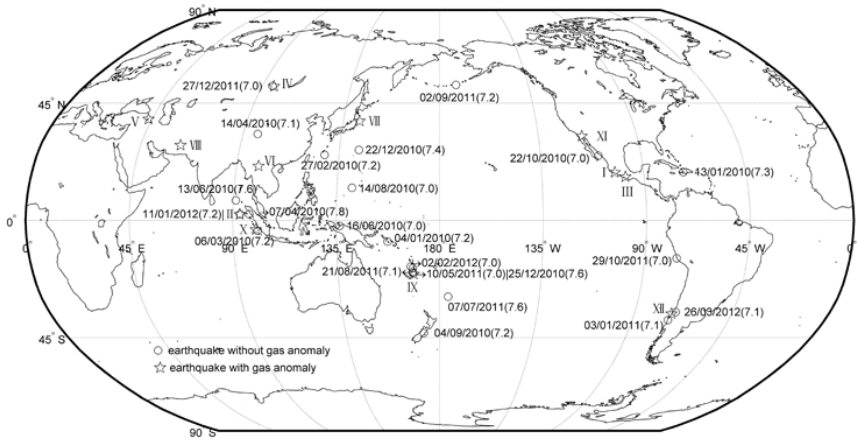
Fig. 1. Epicenter distributions of the 35 studied earthquakes. Arabic numerals are dates in day/month/year and magnitude in brackets. Roman numerals are numbers of earthquake with gas anomaly as shown in Table 2. Table 1. Mean standard deviation of CO (10 16 moleculescm − 2 ) and O 3 (DU) in every month. Jan Feb Mar Apr May Jun July Aug Sep Oct Nov Dec ¯ σ co 5.8 6.4 6.3 5.8 5.2 5.0 4.9 5.4 6.6 7.9 6.9 5.7 ¯ σ O 3 15 17 16 14 13 12 13 13 12 14 16